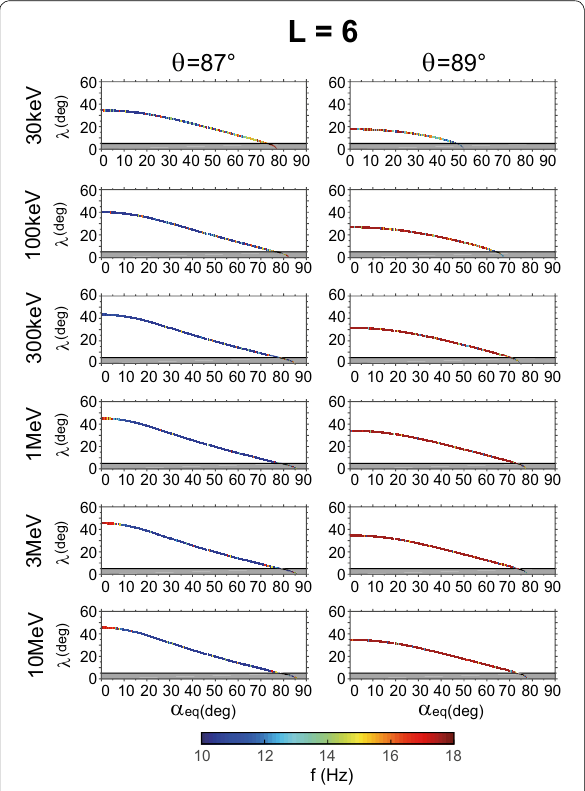
Fig. 3 The same as in Fig. 2, except for L masphere. The adopted wave frequency band remains as 0.0026 < ω/(Ω ce ) eq < 0.0044, but corresponding to a frequency range of 10–18